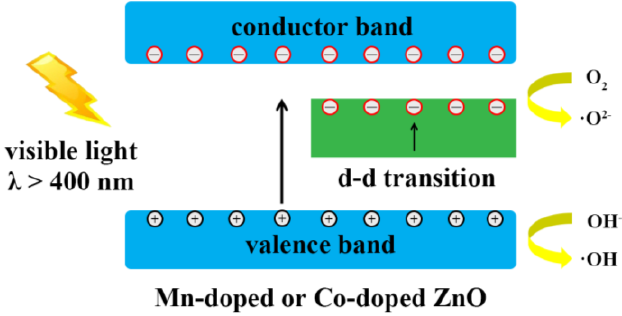
Figure 7. The photocatalytic mechanism of Mn-doped ZnO and Co-doped ZnO nanowires.